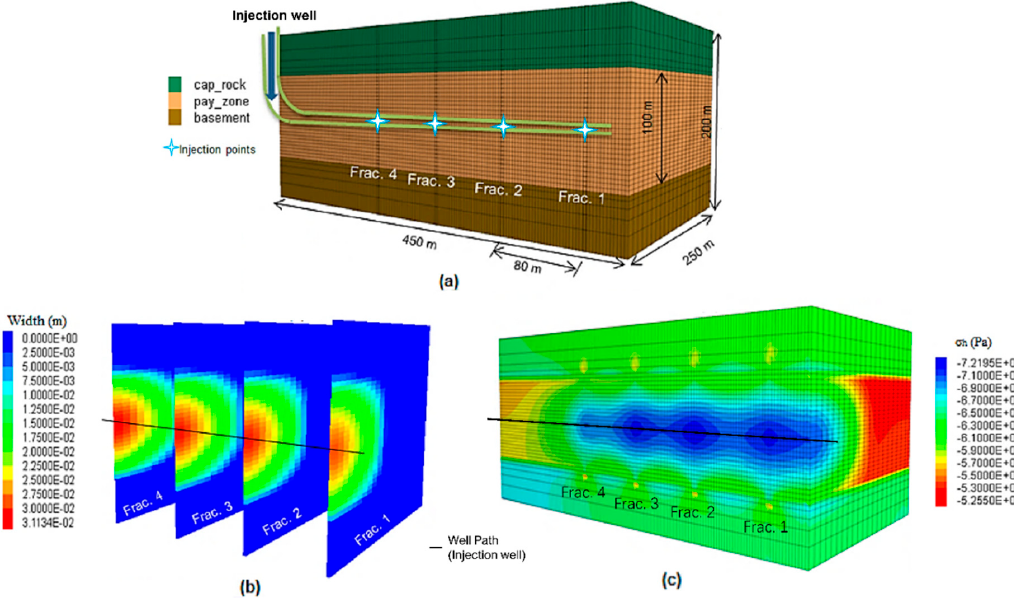
Figure 3 . Illustration of the four created fracture results with (a) the ½ 3D model having four fracture Figure 3. Illustration of the four created fracture results with ( a ) the 1 planes of 80 m fracture spacing, (b) fracture widths, (c) and minimum horizontal stress shadow. planes of 80 m fracture spacing, ( b ) fracture widths, ( c ) and minimum horizontal stress shadow. Energies 2020 , 13 , x FOR PEER REVIEW